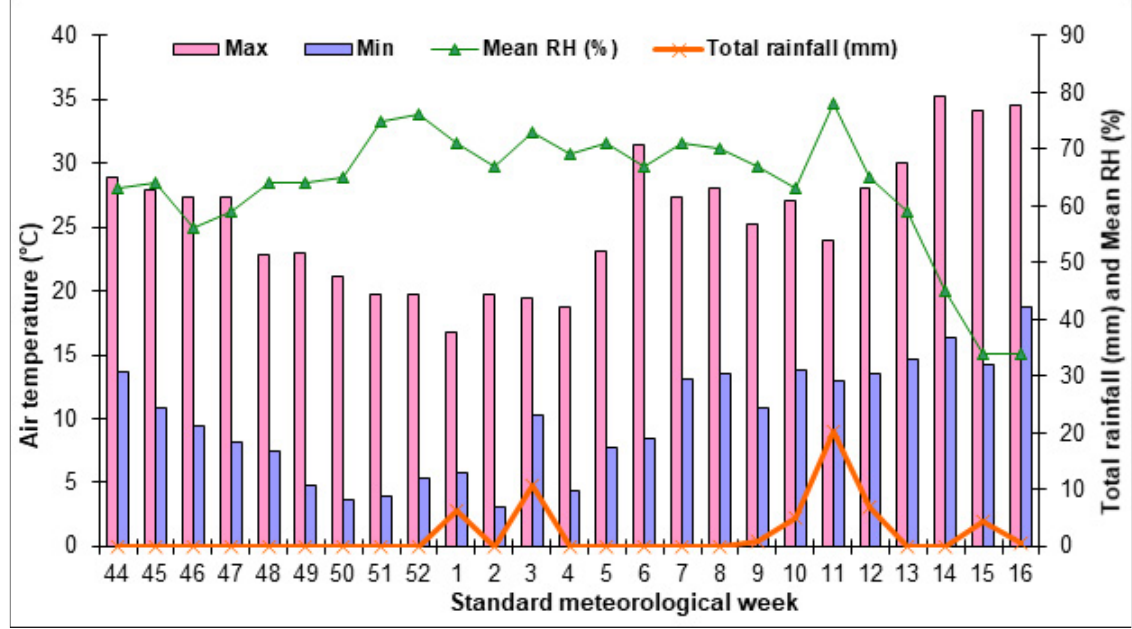
Figure 1: Weekly meteorological data recorded at meteorological observatory at Punjab Agricultural University, Ludhiana during the crop season 2004-2005